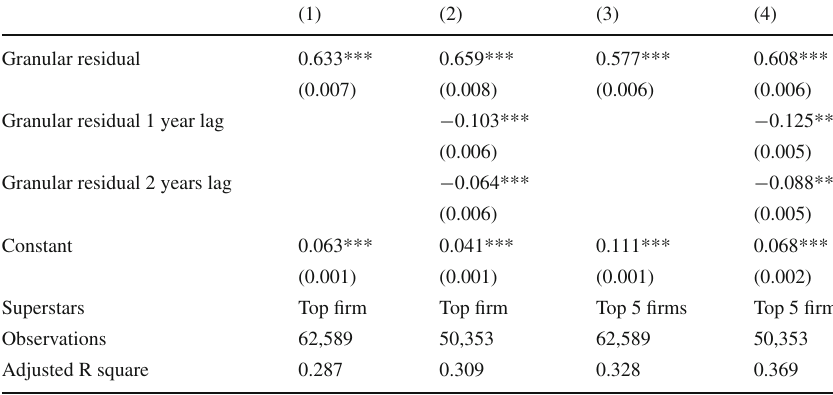
Table 7 Contribution of superstars to variations in Spanish exports, 1997–2015. Data source: Customs